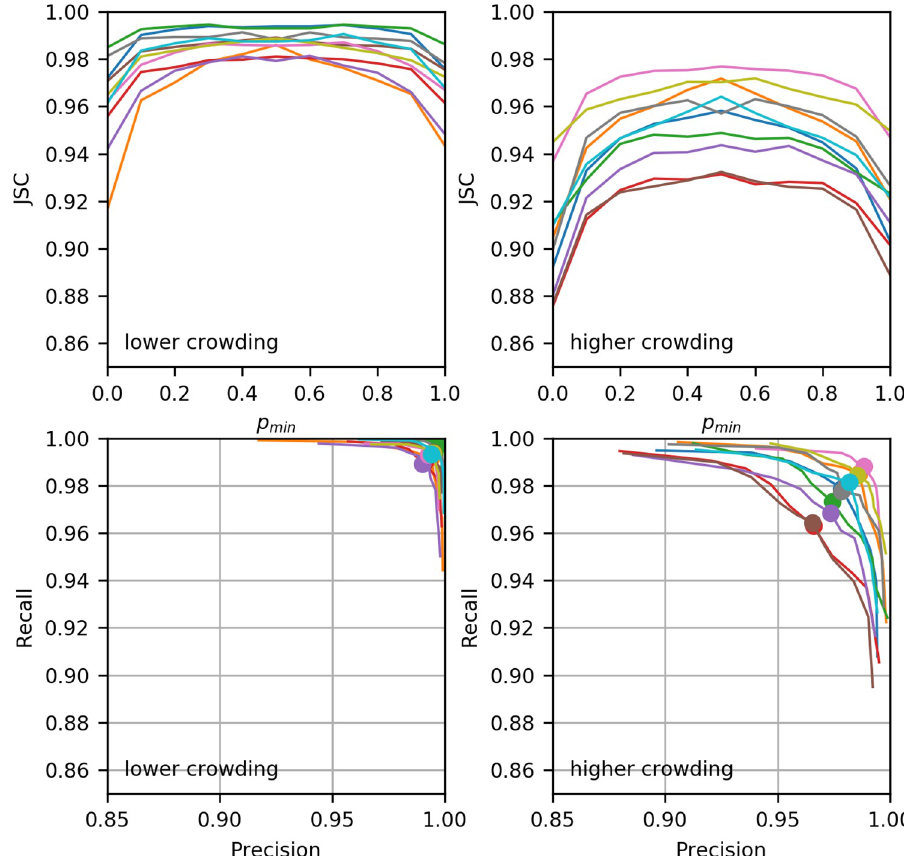
Fig 5. Performance of Biggles tracking for data sets with low and high crowding. From left to right: JSC for less crowded data sets, JSC for more crowded data sets, recall against precision (lower crowding) and recall against precision (higher crowding). The dots in the two right panels mark the values at p